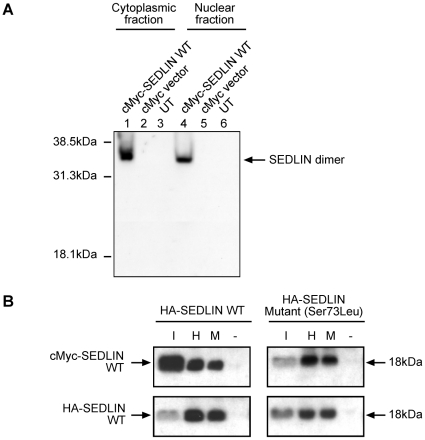
SEDLIN forms homodimers.(A) Western blot analysis, using a monoclonal anti-cMyc antibody, of cell lysates obtained from COS7 cells transfected with cMyc-SEDLIN or cMyc vector alone, and resolved by continuous non-denaturing PAGE; lanes 1-3, cytoplasmic fractions; lanes 4–6, nuclear fractions; lane 1 and 4, transfected with cMyc-SEDLIN wild-type (WT) construct; lanes 2 and 5, transfected with cMyc vector alone; and lanes 3 and 6, untransfected (UT) cells. cMyc-SEDLIN, an 18 kDa protein (Figures 3 and 4) appeared as a 36 kDa protein on non-denaturing PAGE of cytoplasmic and nuclear fractions obtained from COS7 cells transfected with the cMyc-SEDLIN wild-type (WT) construct, consistent with homodimerization of SEDLIN protein. (B) Co-immunoprecipitation of wild-type (WT) cMyc-SEDLIN with wild-type or mutant HA-SEDLINs (data for mutant Ser73Leu, shown). Anti-cMyc antibody co-immunoprecipitated wild-type HA-SEDLIN in the presence of cMyc-SEDLIN (lane M) and anti-HA antibody co-immunoprecipitated cMyc-SEDLIN in the presence of HA-SEDLIN (lane H); in the absence of the anti-cMyc or anti-HA antibodies SEDLIN was not immunoprecipitated (lane -). Five percent of the lysate (input (I)) that was used for the immunoprecipitation was electrophoresed in parallel with immunoprecipitated lysates. Similar results were observed for the other SEDLIN mutants (Asp47Tyr, Phe83Ser, Val130Asp and Gln131Stop) (data not shown).